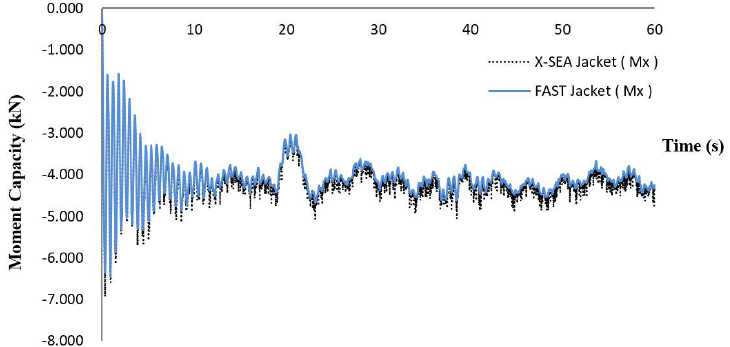
Figure 8. Comparison of the dynamic reaction moment capacity on the jacket support structure about the x-direction resulted from X-SEA and FAST v8 programs.